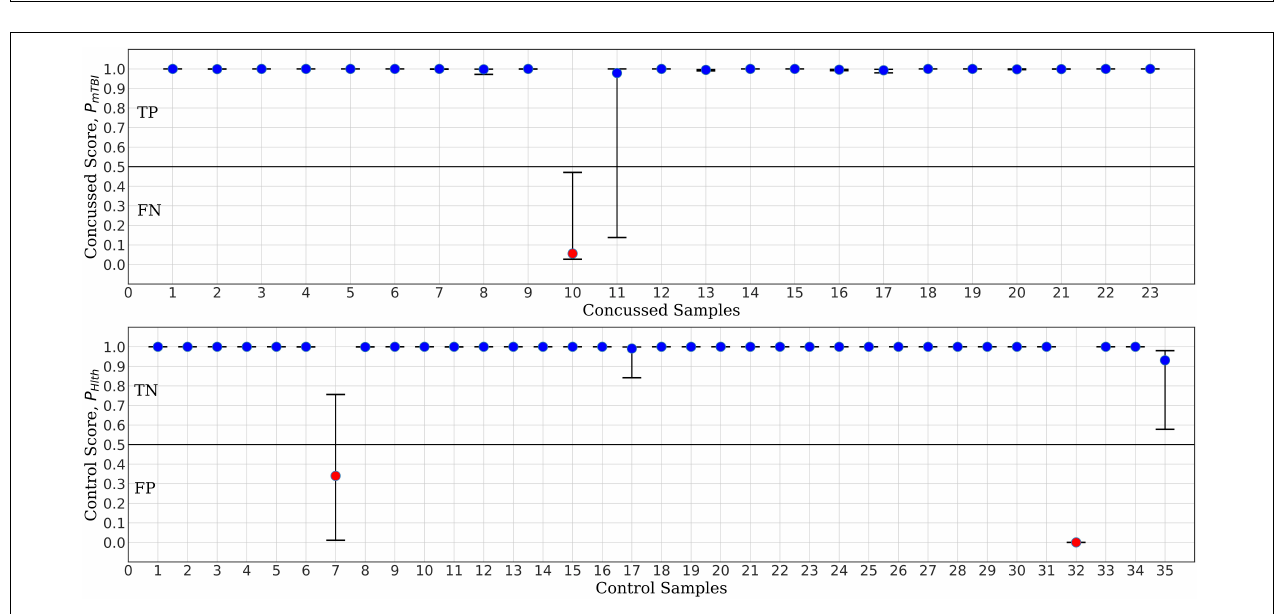
FIGURE 6 | ConcNet 3 MCCV classification test output scores (circle markers), i.e., P Hlth and P mTBI , respectively, for control (bottom) and concussed (top) participants. The horizontal axis marks the different participants in each group, and the vertical axes correspond to test output scores in the range [0, 1]. The error bars are based on the classification results of 100 Monte Carlo cross validation experiments. Blue markers correspond to participants who were correctly classified at least 50% of the time, while red markers correspond to misclassified participants (median classification score less than 0.5).